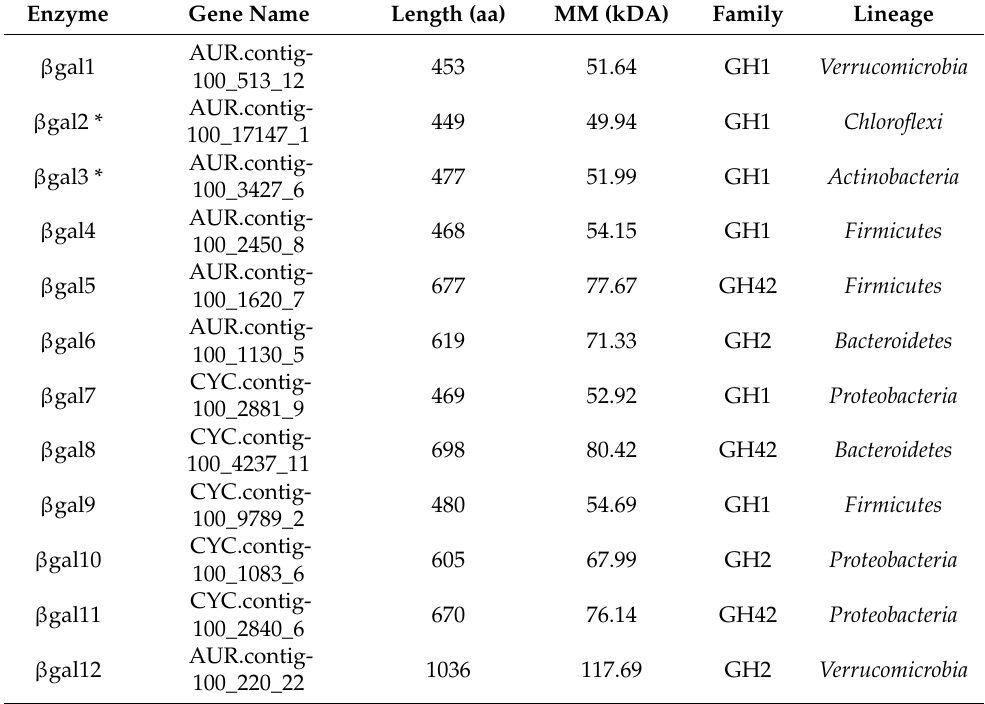
Table 2. Putative β -galactosidases selected from metagenomes. Enzymes noted with * could not be amplified by PCR. MM, molecular